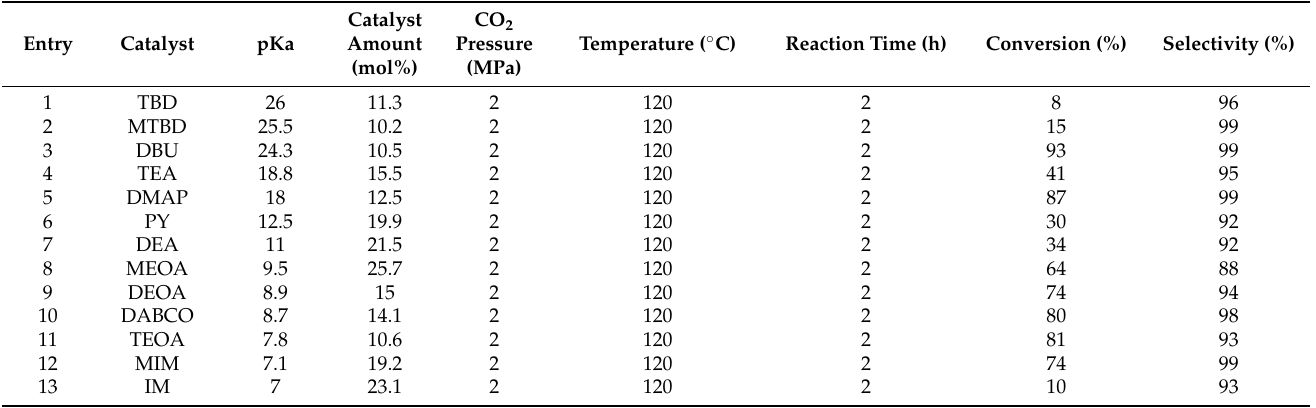
Table 2. The effect of organic amines on the conversion of PO